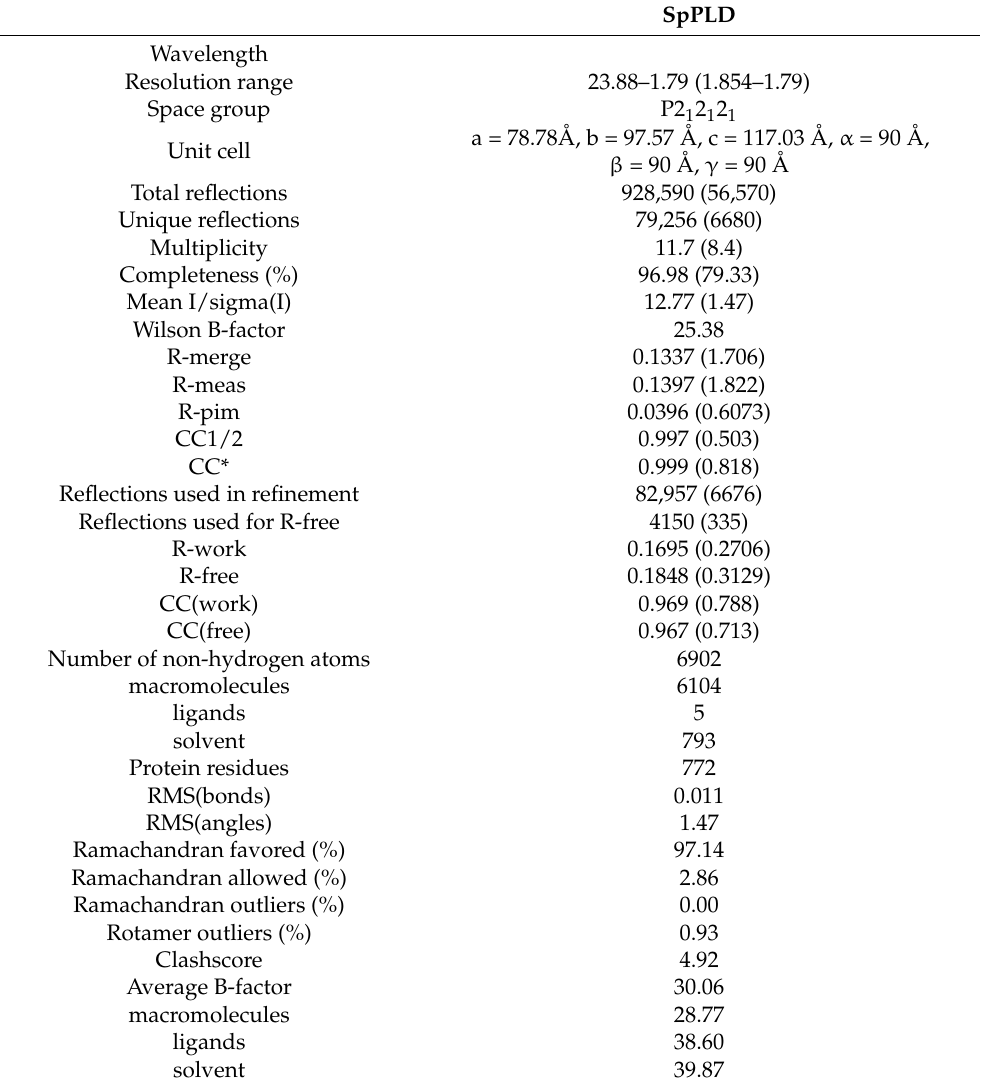
Table 2. Data collection and refinement